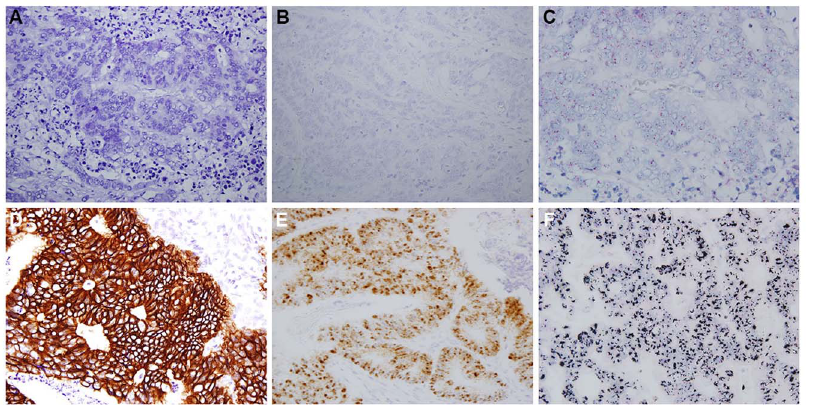
Figure 1. Representative figures of HER2 status by IHC, ISH, and dual-color SISH in CRC patients. (A) IHC 0 (40 6 objective); (B) score 0 by mRNA ISH (40 6 objective); (C) HER2 gene disomy (60 6 objective); (D) IHC 3 + ; (E) score 4 by mRNA ISH; (F) HER2 gene amplification ( HER2 /CEP17 ratio $ 2).